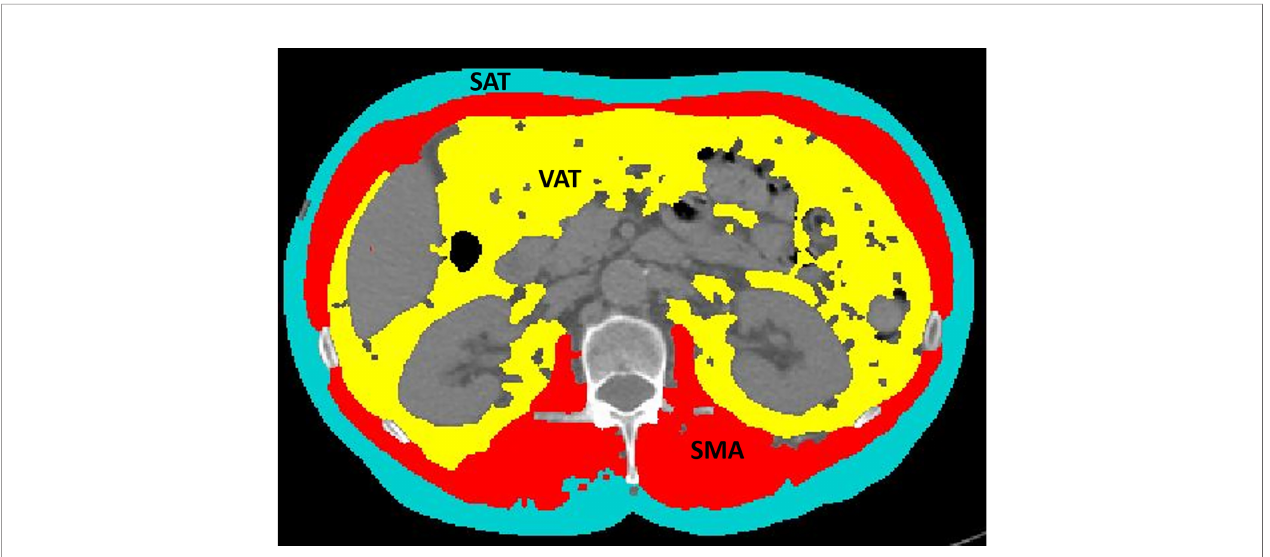
FIGURE 1 | An example of segmentation of skeletal muscle area (red), visceral adipose tissue (yellow), and subcutaneous adipose tissue (light blue) from an axial image at the level of L3 of a CT scan performed as routine pretreatment staging. The colored parts are quanti fi ed as areas (cm 2 ) by the software. The excluded parts include abdominal organs, such as liver, kidneys, and bowel (dark gray), as well as bones, such as vertebral body and ribs (light gray and